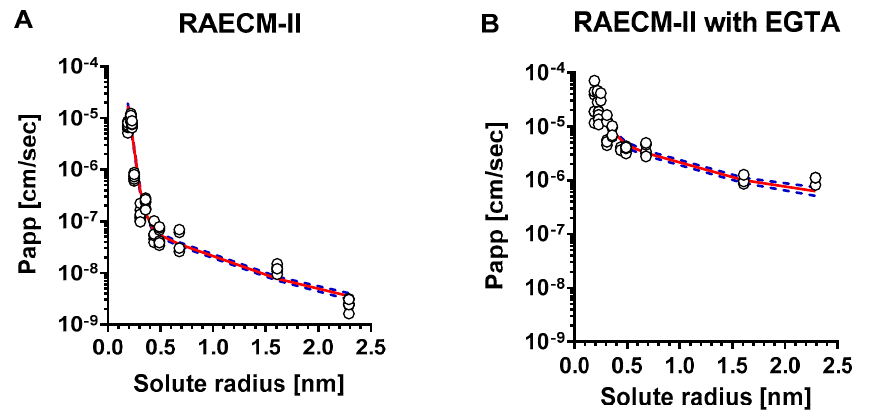
Figure 2. Heteropore analysis of P app across RAECM-II. P app across RAECM-II in the absence ( A ) and presence ( B ) of EGTA were analyzed using a maximum likelihood optimization approach, yielding small and large equivalent pore characteristics shown in Table 6. Circles represent individual P app , and the solid curve in red denotes the composite equivalent pore characteristics that best fit the observed P app versus solute radius data. Blue dotted curves represent solid red curve ± standard errors. Figure A2 in Appendix A shows the relationship between mean values of P app and solute size, similar to that shown above in Figure 2 (based on optimization using all entries of P app ). Table 6. Heteropore characteristics of RAECM-II. Radius and number of small and large equivalent pore populations based on maximum likelihood optimization approach using all entries of P app in the absence and presence of EGTA. Equiv- alent pore number is per nominal surface area (1 cm 2 ) of RAECM-II.